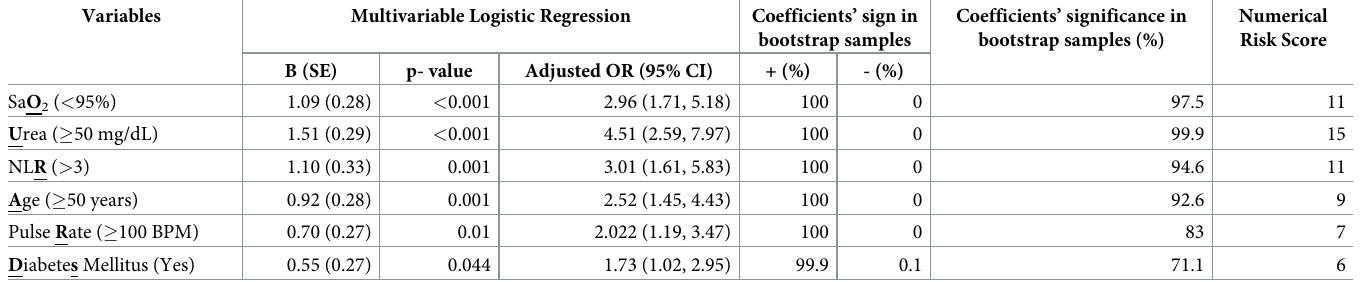
Table 2. Multivariable logistic regression showing the adjusted odds ratio of predictors influencing mortality, among COVID-19 infected patients admitted to hospital. Variables Multivariable Logistic